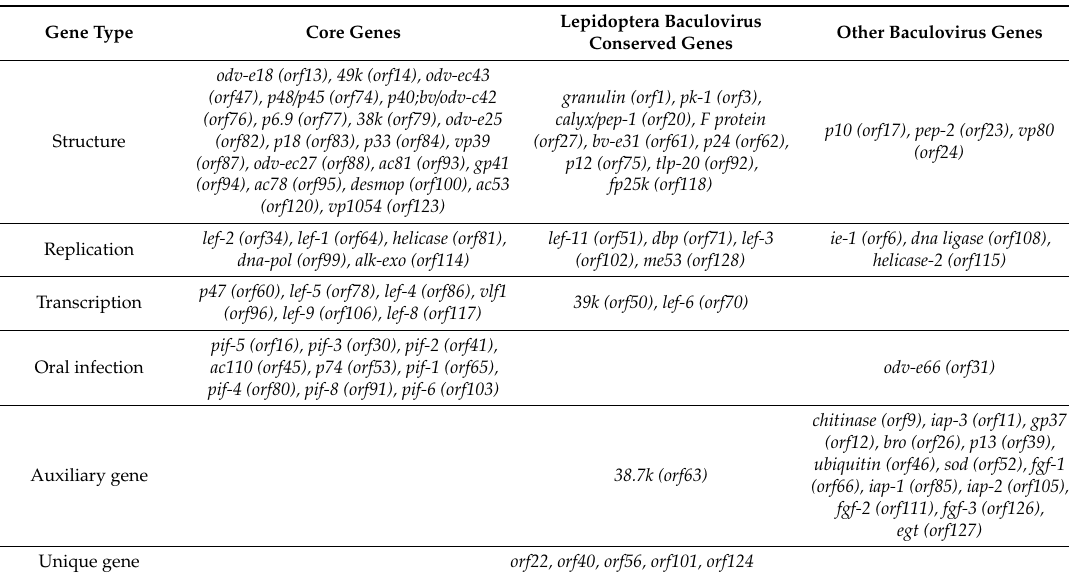
Table 1. Gene contents of